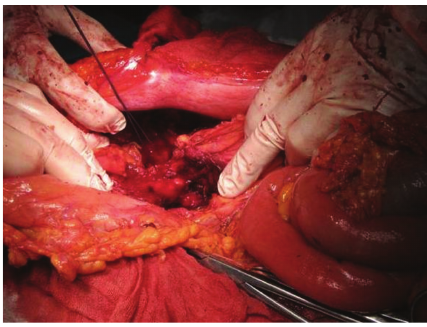
Figure 5: Intraoperative aspect: ligation of the splenic artery at the level of the vascular